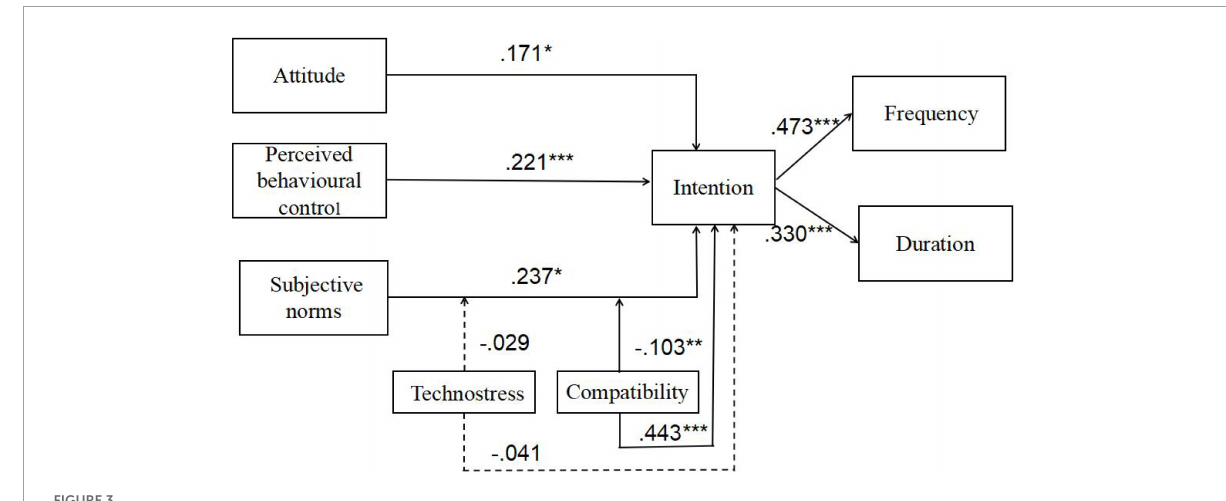
FIGURE3 The research model with its path coefficients. *** p < 0.001, ** p < 0.01, * p <